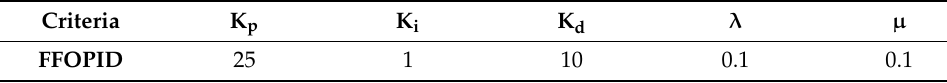
Table 4. The optimal values of the fuzzy FOPID controller.